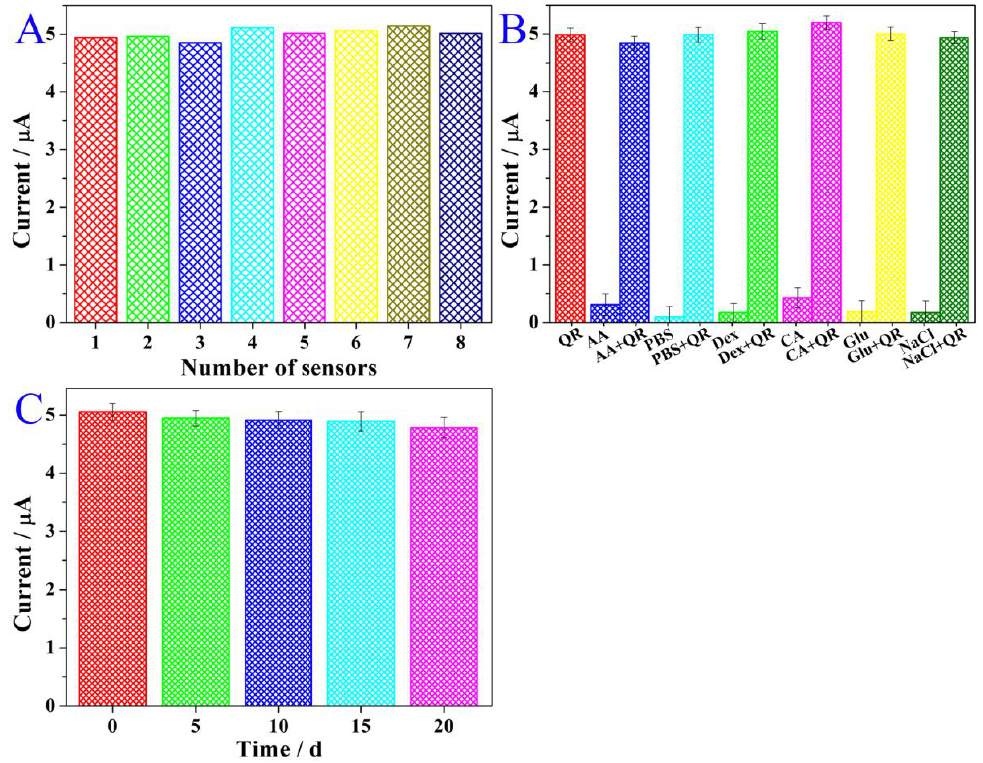
Figure 9. The reproducibility ( A ), selectivity ( B ), and stability ( C ) of sensor in PBS w ith 6 μM QR